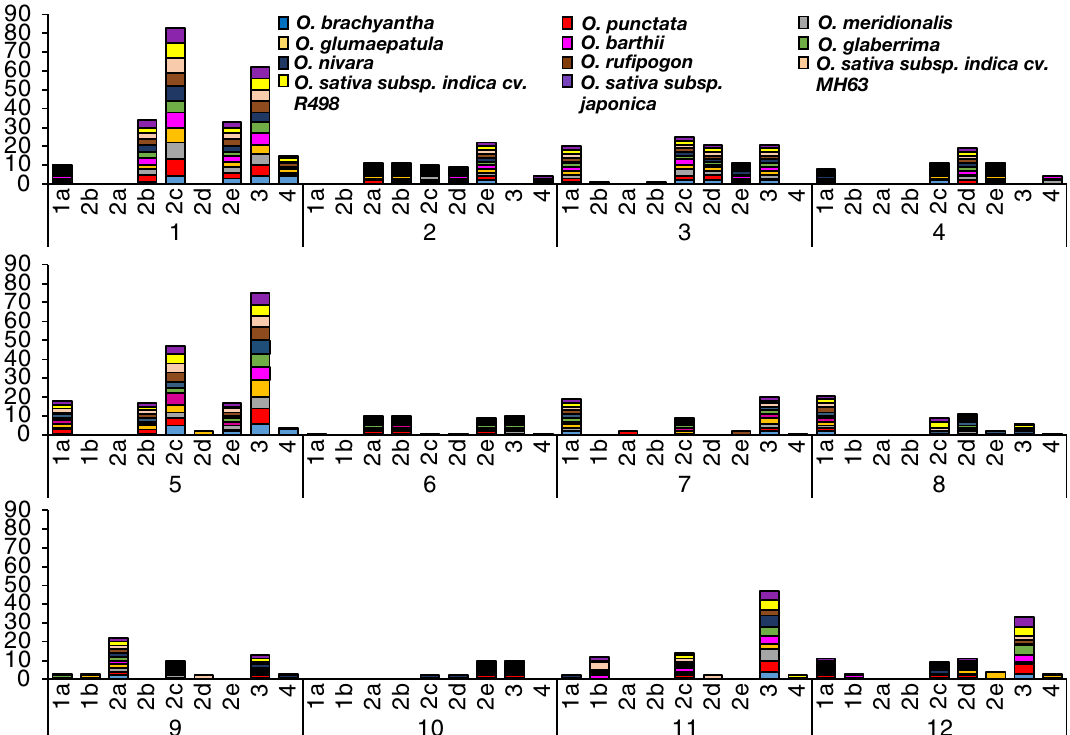
Figure 2. WRKY groups are consistent across Oryza but are not equally found across chromosomes. Stacked columns represent the number of WRKY genes identified under the WRKY group classification for each of the 12 chromosomes in Oryza . Different colors represent different Oryza species. Species are arranged based on divergence from the Oryza ancestor, from oldest to